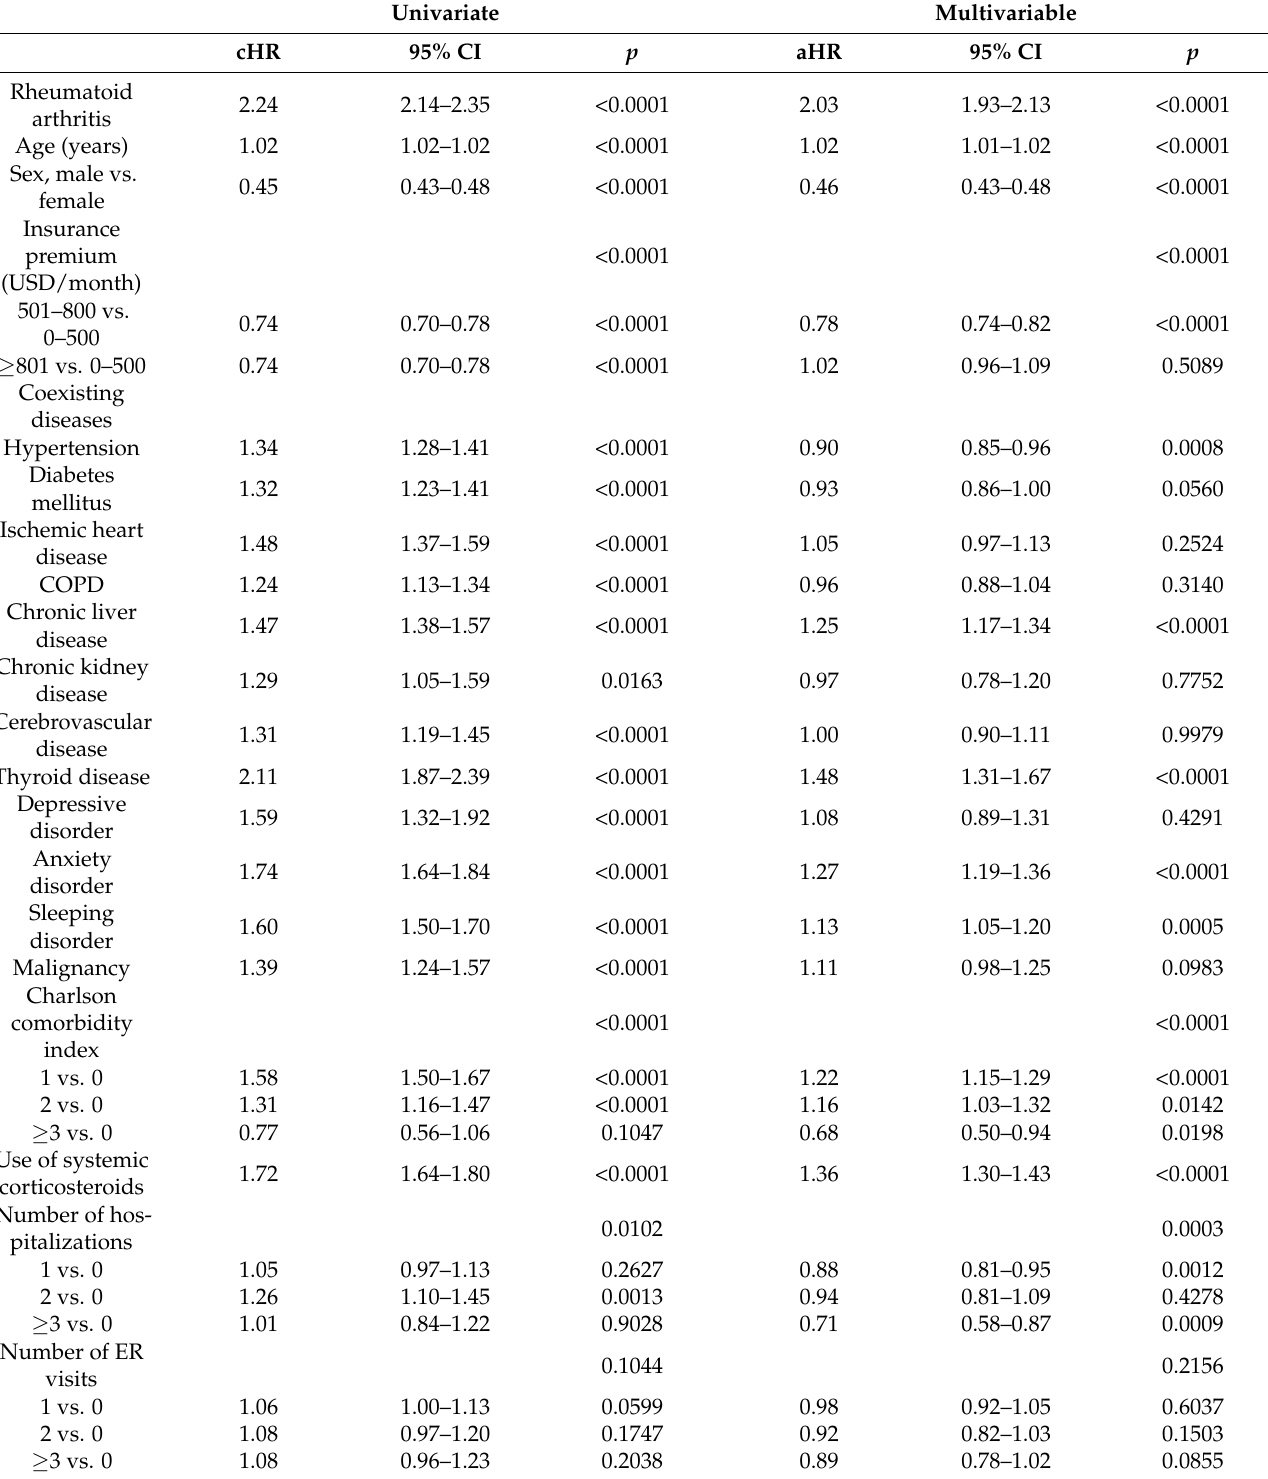
Table 3. Univariate and multivariable analyses for dry eye